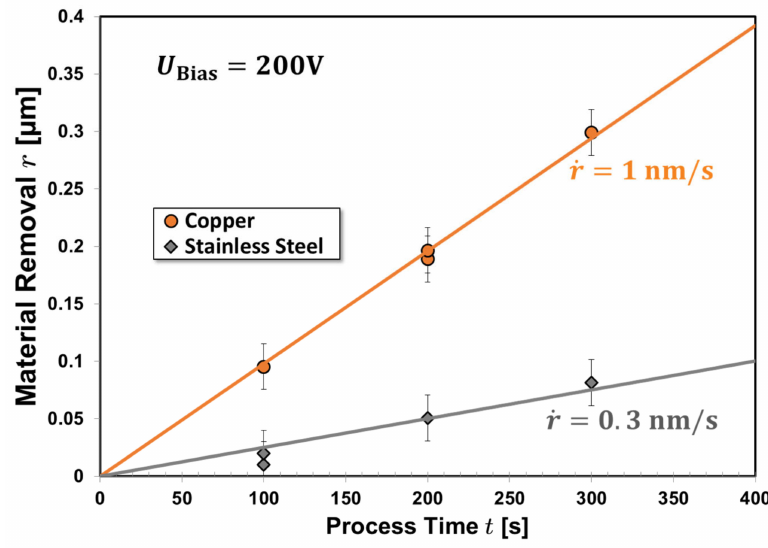
Figure 3. Static material removal r vs. process time t for the used substrate materials copper and stainless steel.